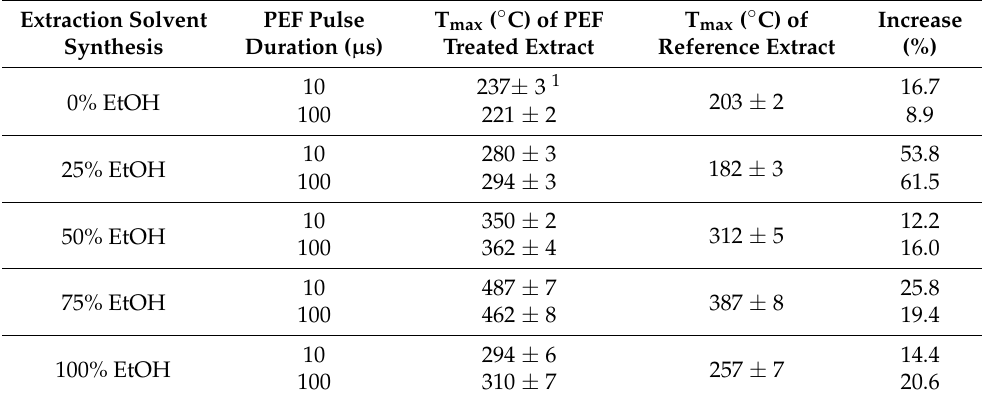
Table 1. Oxidation temperature (T max ) of the various samples during DSC determination. Extraction